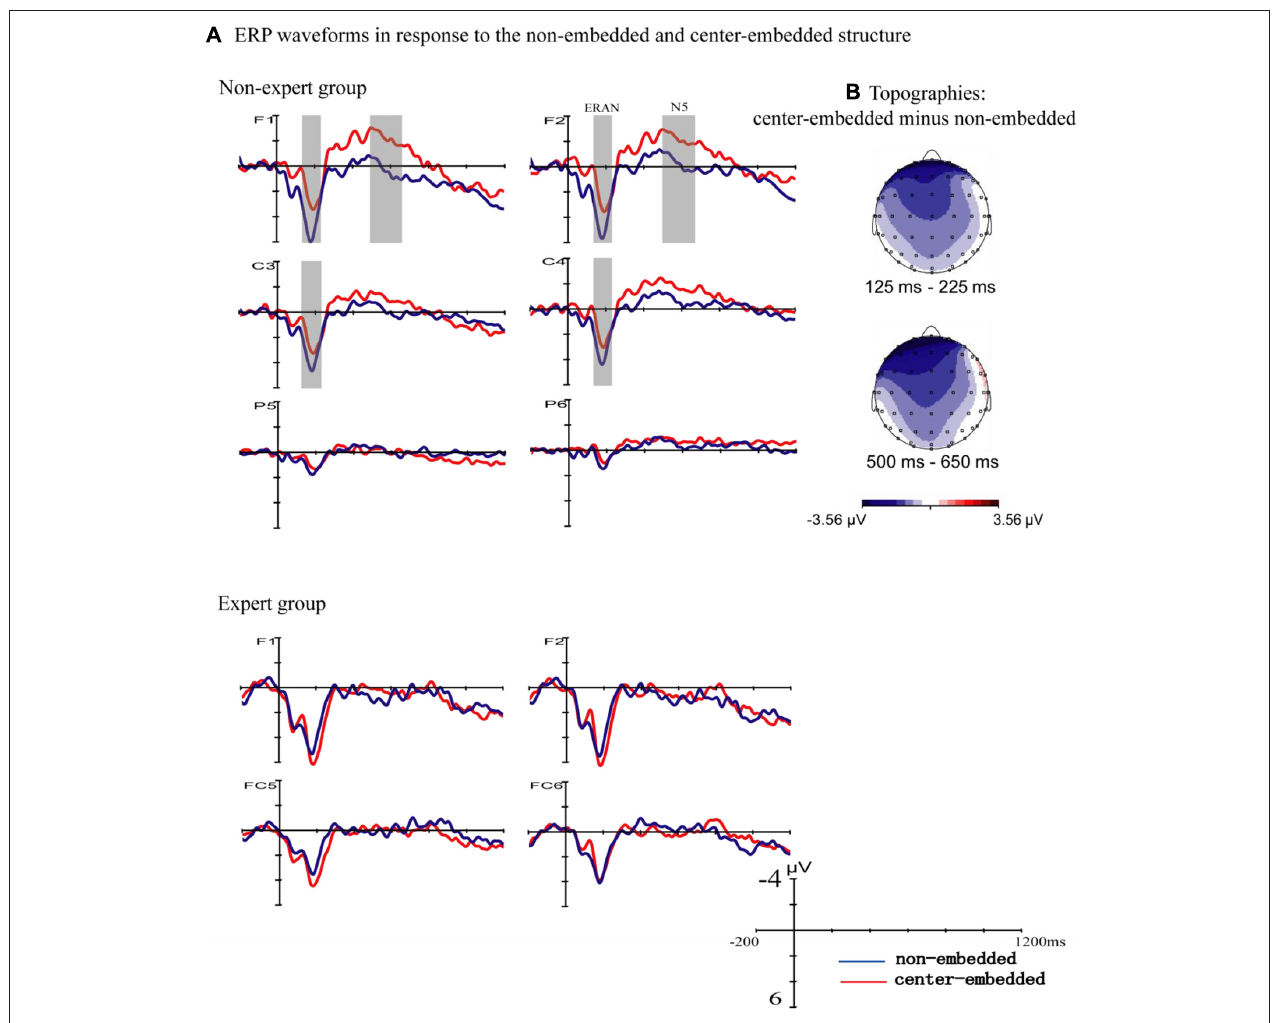
FIGURE 2 | Event related potentials (ERPs) to the final chords with the two structures. (A) The ERPs evoked by the final chords in the non-embedded and center-embedded conditions are presented separately for the non-expert and expert groups. In the non-expert group, compared to the ERPs evoked by the non-embedded condition (blue waveforms), the center-embedded condition (red waveforms) evoked an early negativity (around 125–225 ms), and a later negativity (around 500–650 ms). The gray shaded areas reflect a statistically significant difference between the two conditions. In the expert group, the ERP effects did not significantly differ between the two conditions. (B) The scalp distribution of the early and late ERP effects elicited by the final chords of different conditions (difference potentials: center-embedded minus non-embedded) in the non-expert